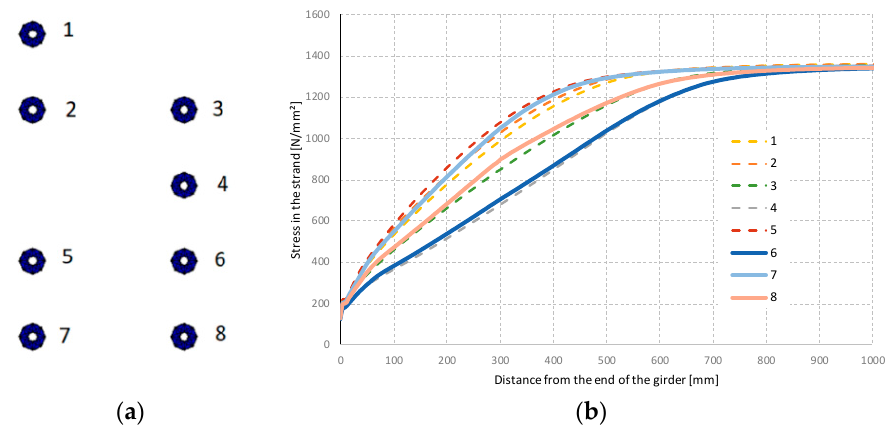
Figure 6. Longitudinal stresses in the strands (FEA data): ( a ) Strand numbering; ( b ) Strand stresses. The strain gauges are installed every 200 mm up to a distance of 1600 mm from the end face. The instrumented girder at the precast plant is shown in Figure 7.